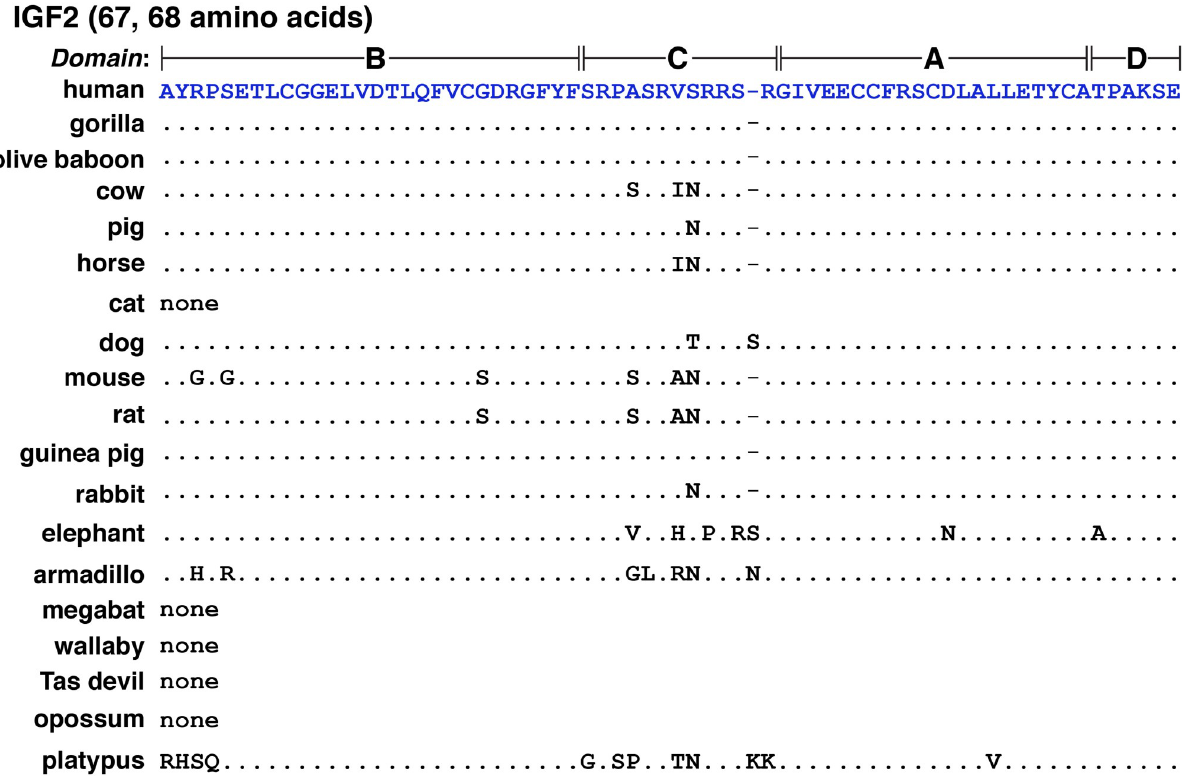
Fig 6. Alignments of mature IGF2. Amino acid sequences of IGF2 (67 or 68 amino acids) from different mammals are illustrated in single letter code. Dots depict identities, and differences among species are indicated. A dash depicts no residue. No IGF2 of this type could be identified in cat, megabat, wallaby, Tasmanian devil, or opossum, as indicated by the word ‘none’ (but see Fig 7).